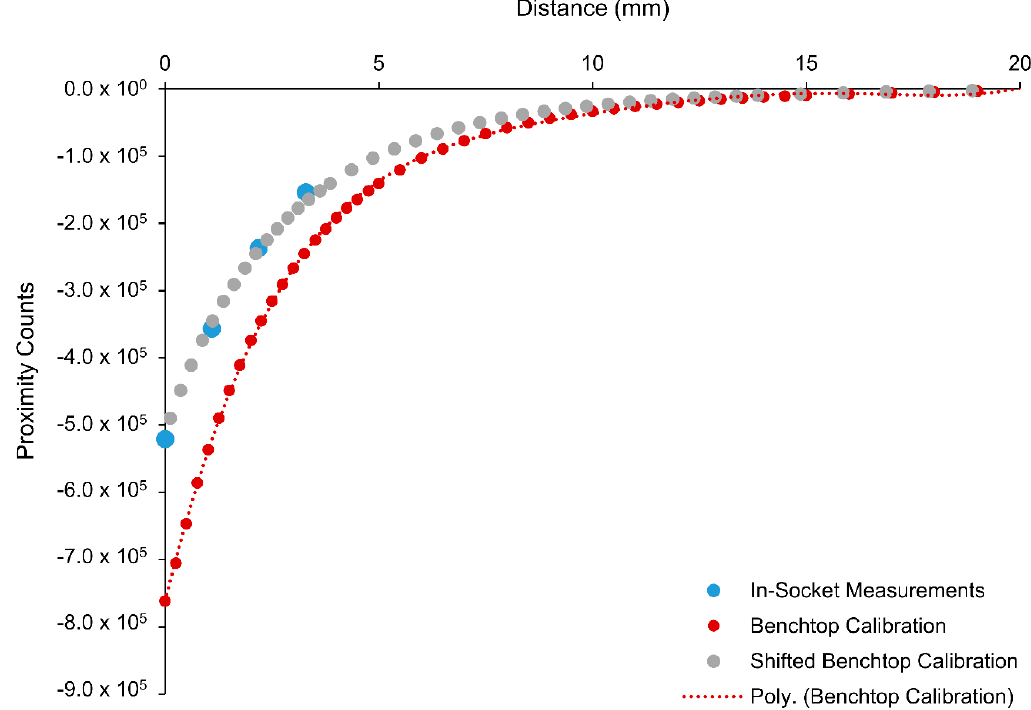
Figure 4. Benchtop calibration obtained from one location on a ferrous liner, in-socket measurements from one sensor in the socket for Participant 1, and the x-axis offset-corrected benchtop calibration to accurately represent the embedded sensor’s response.